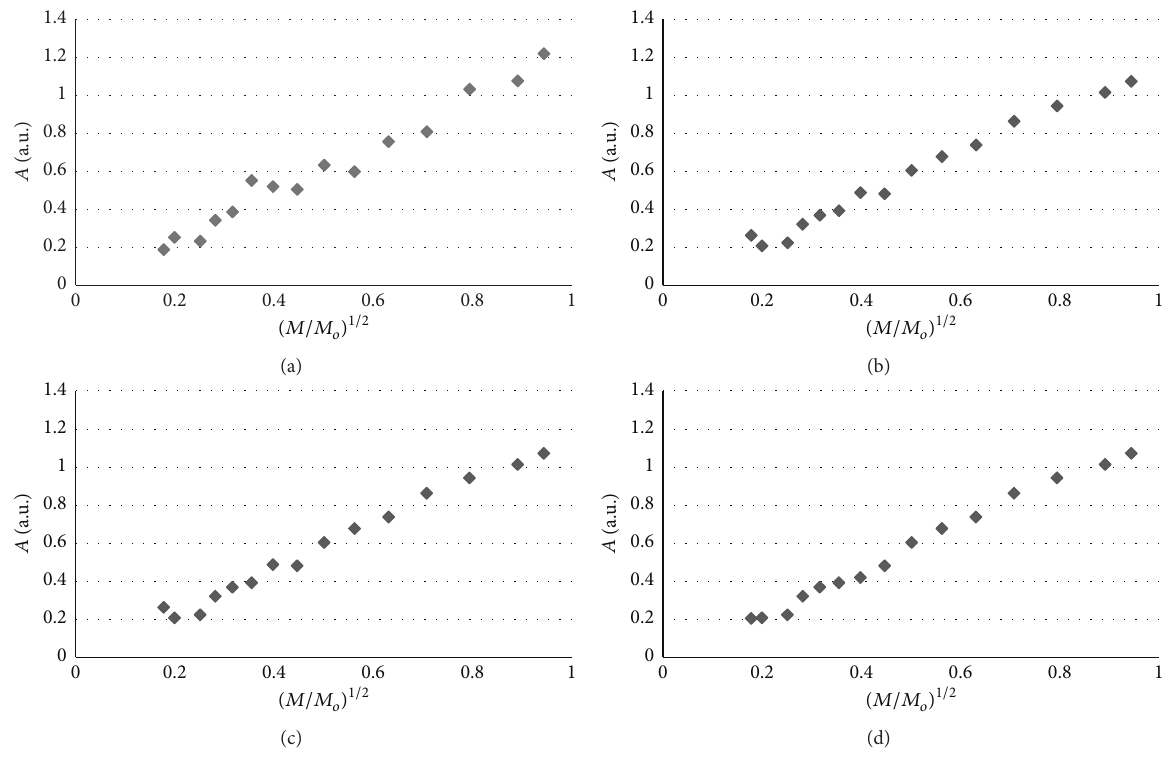
Figure 5: The effect of microwave power ( 𝑀/𝑀 𝑜 ) on amplitudes ( 𝐴 ) of the EPR spectra of UV irradiated salicylic acid during (a) 15 minutes, (b) 30 minutes, (c) 45 minutes, and (d) 60 minutes. 𝑀 : microwave power used during the measurement and 𝑀 𝑜 : total microwave power produced by klystron (70 mW).